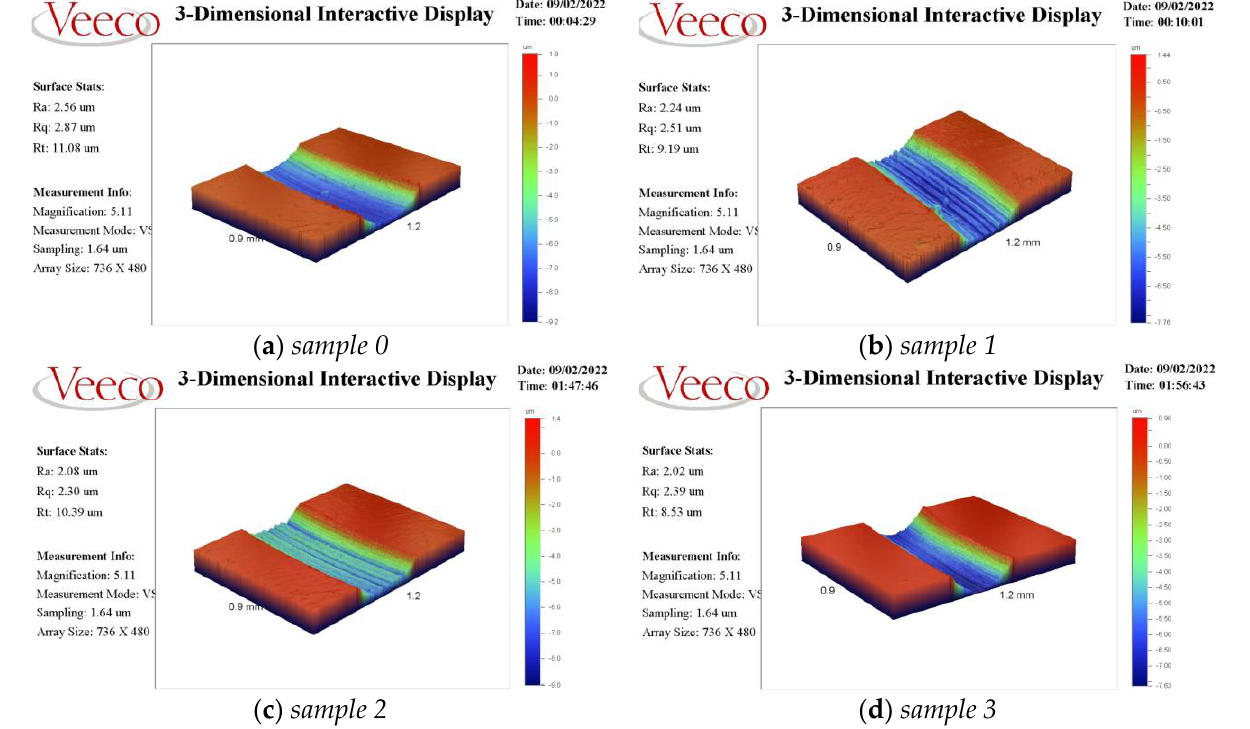
Figure 6. Three-dimensional images of grooves on the surface of the samples tested.